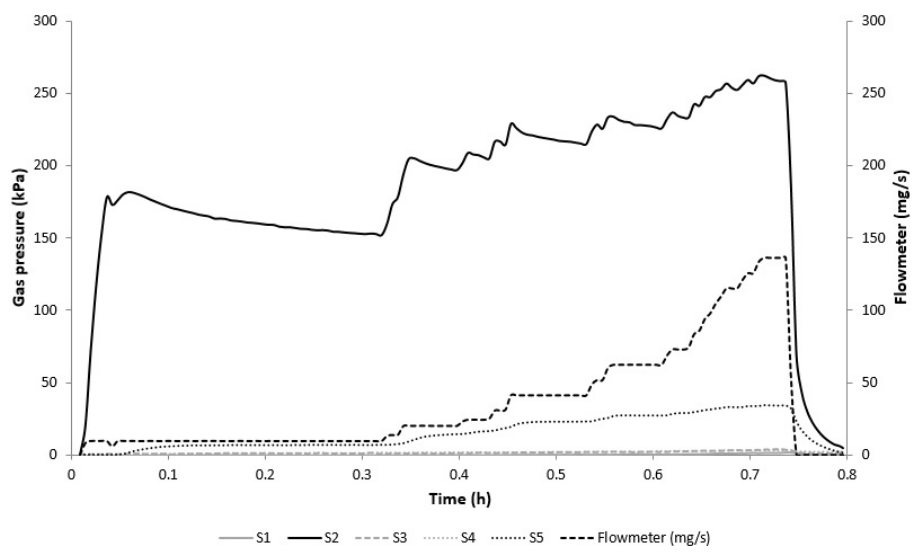
Figure 3. Evolution of borehole pressure in the methane injection test.